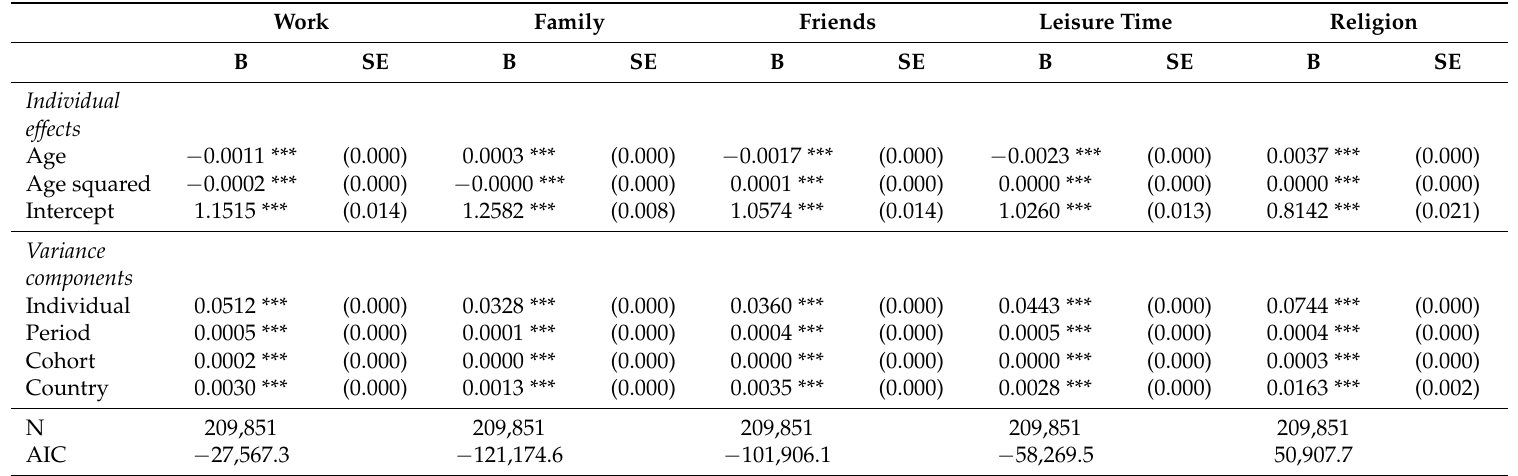
Table A7. The HAPC models of the relative importance of life aspects, only time related variables.